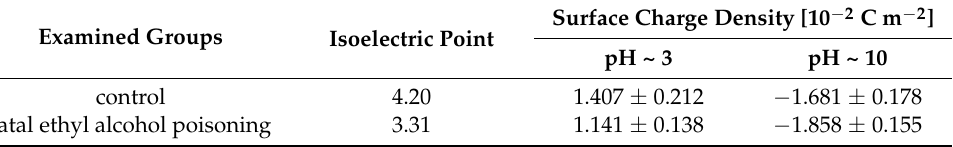
Table 2. The surface charge density and isoelectric point values for thrombocytes (control and fatal ethyl alcohol